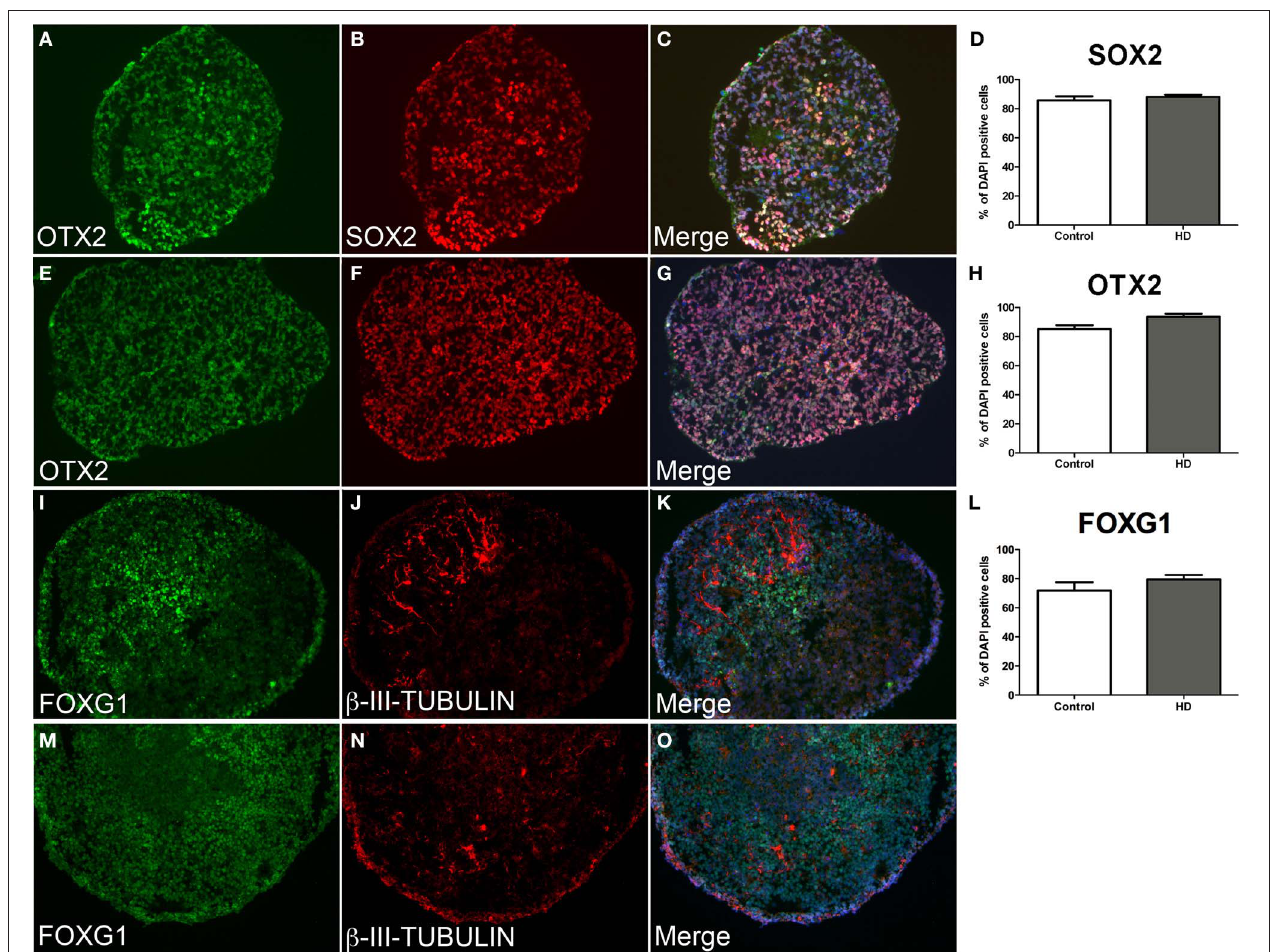
FIGURE 3 | Equivalent neurosphere neural progenitor gene expression and forebrain specification from HD and control cryosectioned immunostained neurospheres. Neurospheres at d10 of differentiation from HD line SI-187 (A–C) and control line H9 (E–G) , demonstrate robust expression of the telencephalic marker OTX2 (green) and similarly the neural progenitor marker SOX2 (red). Merged images demonstrate co-expression of OTX2 and SOX2 and quantitative evaluation shows no significant difference